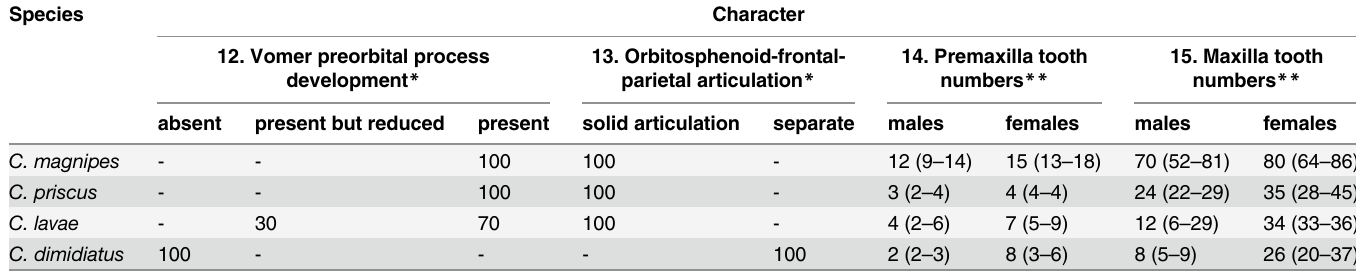
* Frequencies — calculated by considering right and left sides separately. Ten specimens of each species were examined. ** Tooth counts — number of functional teeth on the single, unpaired premaxilla and both right and left maxillae. Figures represent means, followed by the range in parentheses. Five males and fi ve females of each species were examined.